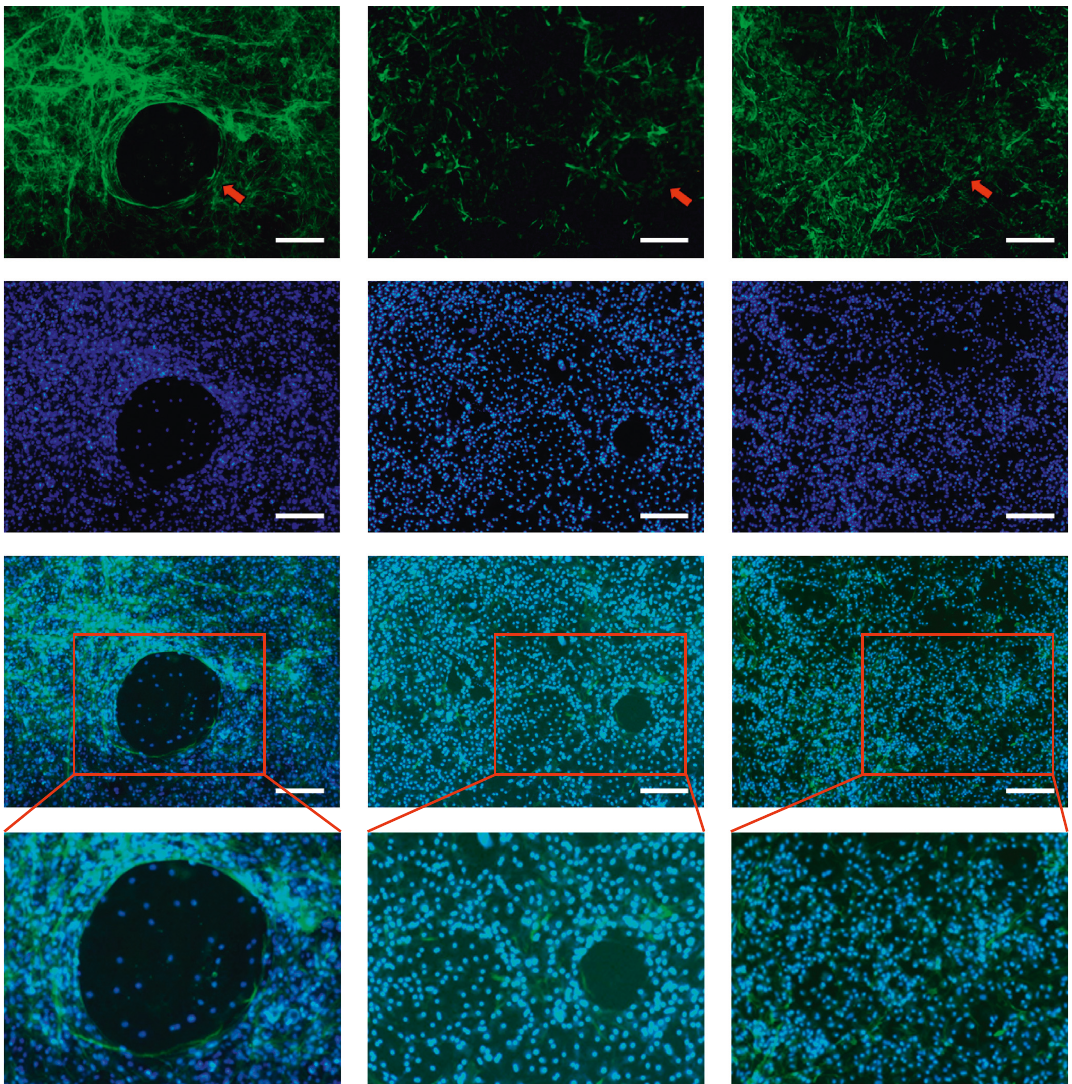
Figure 3: Met impaired osteoclastic formation of F-actin rings; BMMs induced and cultured in a medium with the addition of M-CSF (50ng/mL), RANKL (100ng/mL), and 0, 200, or 400 μ M Met for 5d; then, the cells were stained with phalloidin and DAPI (scar bar � 100 μ m). The red arrows indicate the F-actin